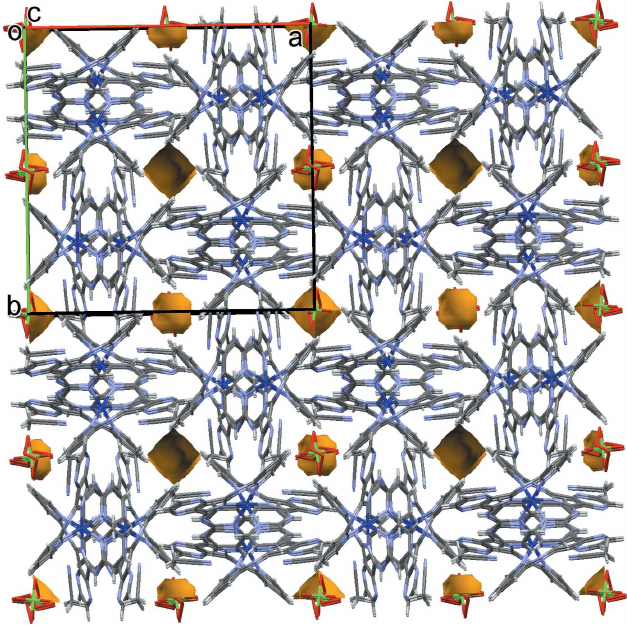
Figure 3 A view along the c axis of the crystal packing of the title compound. The small cavities in the crystal structure are represented in yellow–brown ( Mercury ; Macrae et al. , 2008).